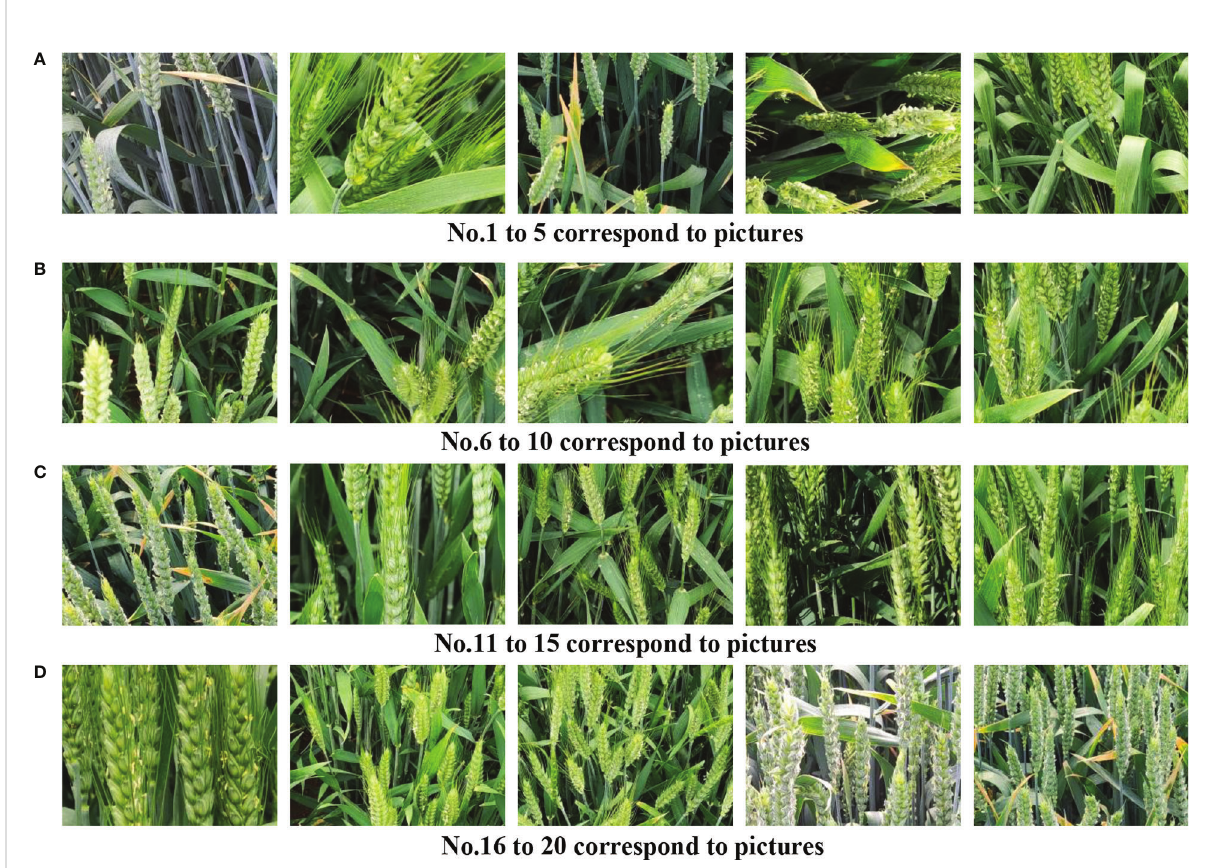
FIGURE 11 Twenty images with different numbers of spikes, different varieties, different shooting angles and planting densities. (A) The numbers 1 to 5 correspond to the picture. (B) The numbers 6 to 10 correspond to the picture. (C) The numbers 11 to 15 correspond to the picture. (D) The numbers 16 to 20 correspond to the